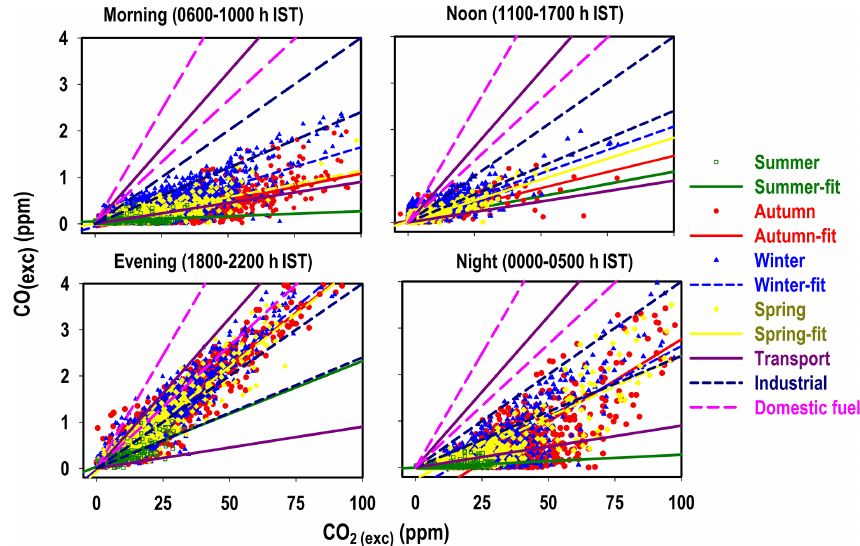
Figure 7. Scatter plots and regression fits of excess CO (CO (exc) ) vs. excess CO 2 (CO 2(exc) ) during morning (06:00–10:00), noon (11:00– 17:00), evening (18:00–22:00) and night (00:00–05:00) hours for all four different seasons. Excess values of both species are calculated after subtracting their background concentrations. Each data points are averaged for 30min. Emission ratios range of CO / CO 2 for different sources from the literature are also plotted in each